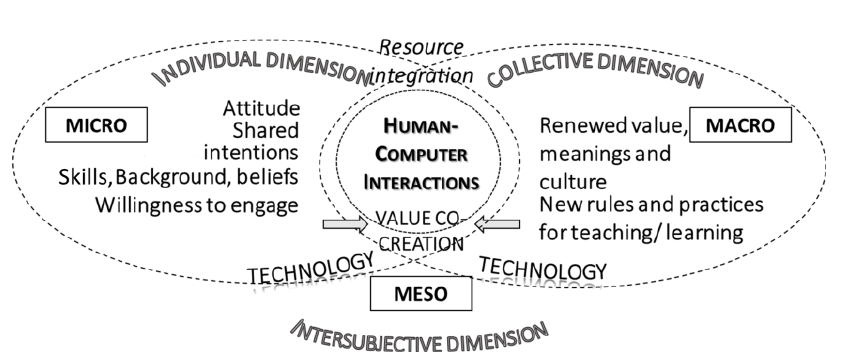
Fig. 1. The enablers of value co-creation in education